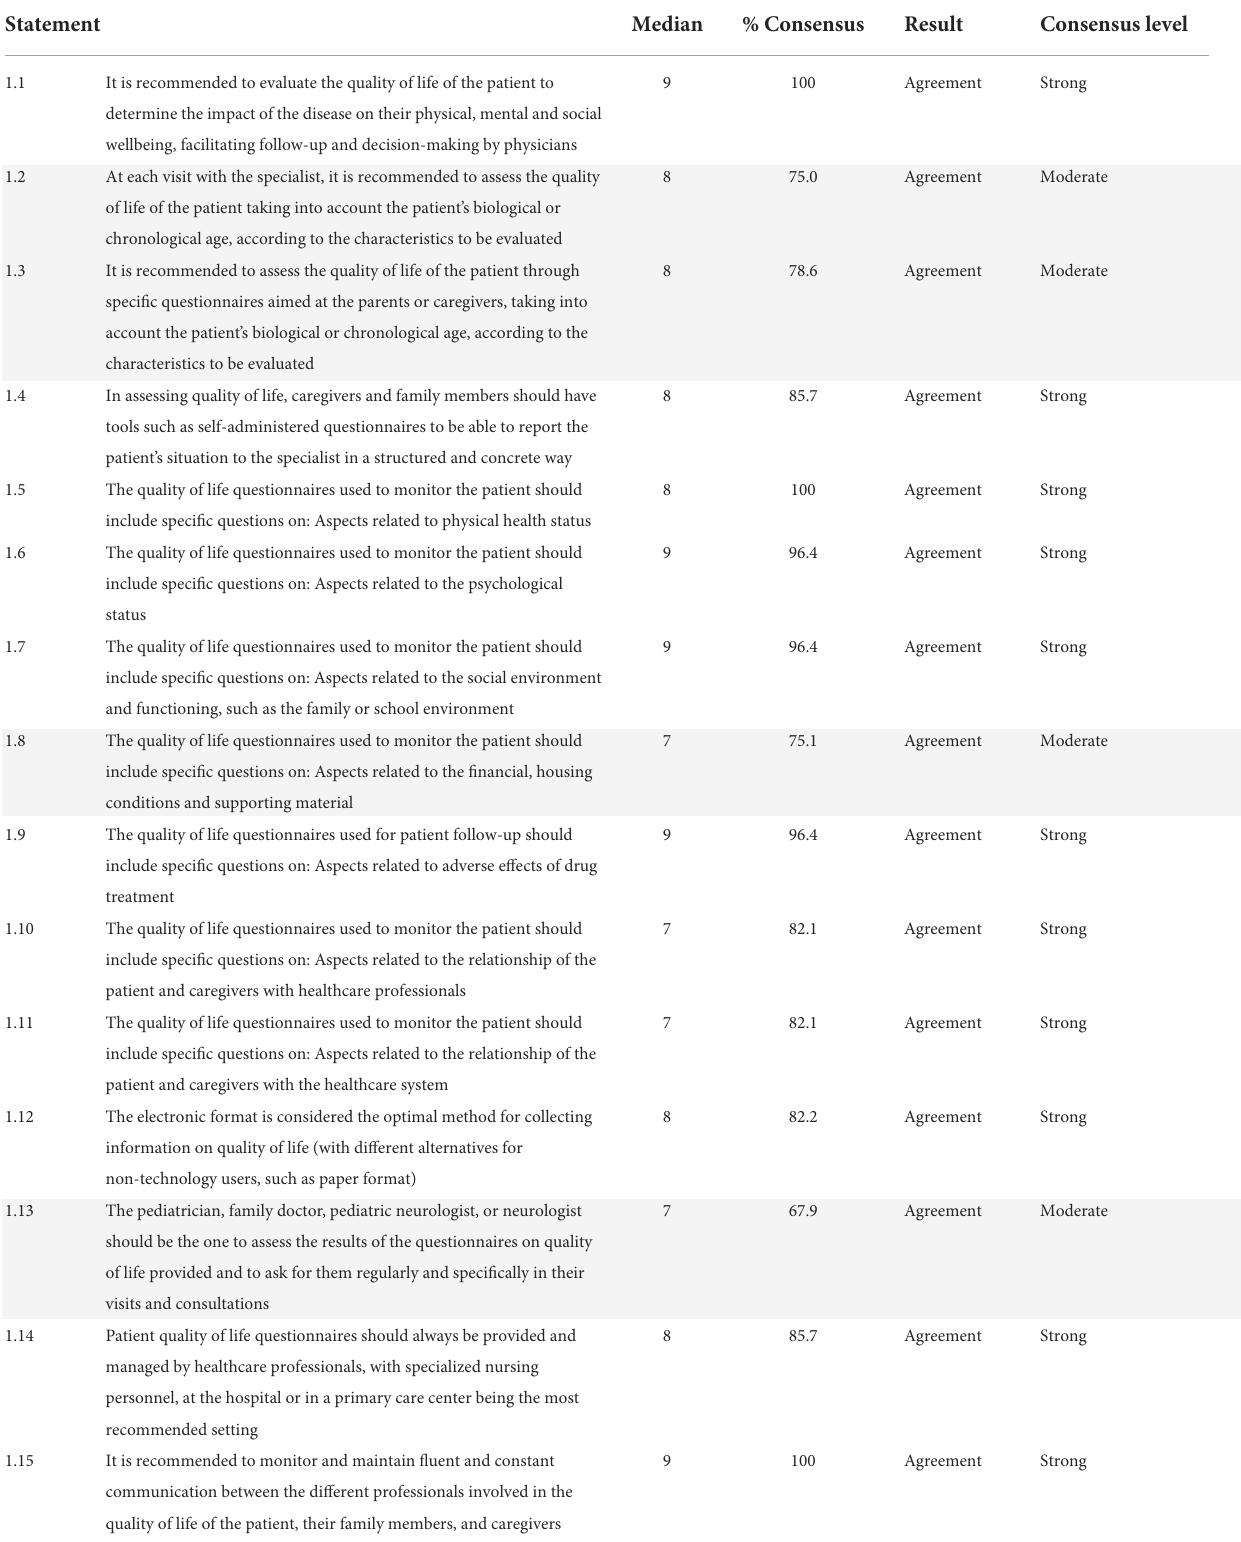
TABLE 1 General aspects on the assessment of the quality of life of patients with Dravet syndrome (block